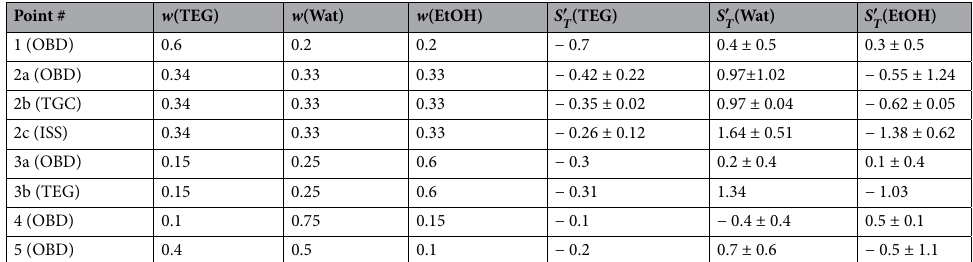
Table 1. Summary of the Soret coefficients measured in microgravity (ISS) 15 and by two ground-based techniques OBD (optical beam deflection) and TGC (thermo-gravitational column) from Refs. 15,28 . Soret 3 K − 1 ) coefficients in units of ( 10 − , content w in mass fractions. The error bars are not displayed if they are missing in the original